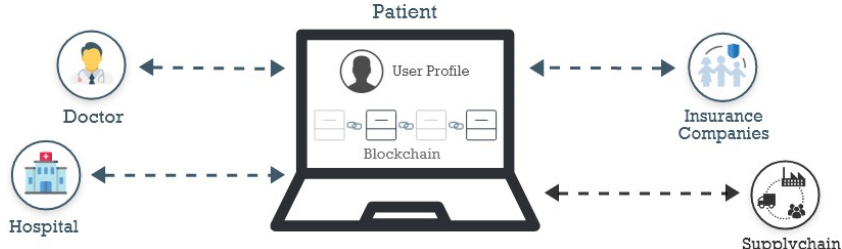
Figure 6. Blockchain in